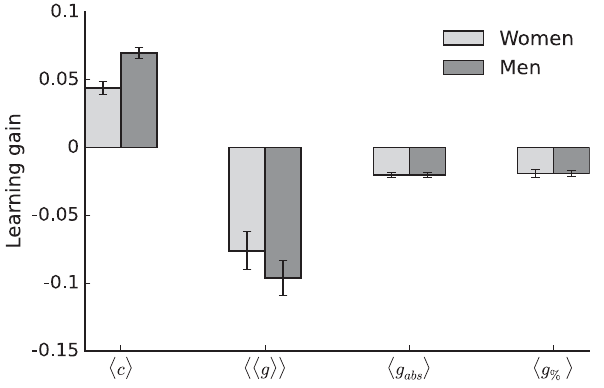
FIG. 3. Learning gains on each of the four different metrics for gain given in Table V. From left to right these are average normalized change h c i ; Hake gain ⟪ g ⟫ ; average absolute gain h g i ; and average percent increase over pretest h g abs represent the standard error of the mean. The difference between the gains for men and women is statistically significant only in the case of normalized change h c i (independent sample t test, p ≪ 0 . 01 ).